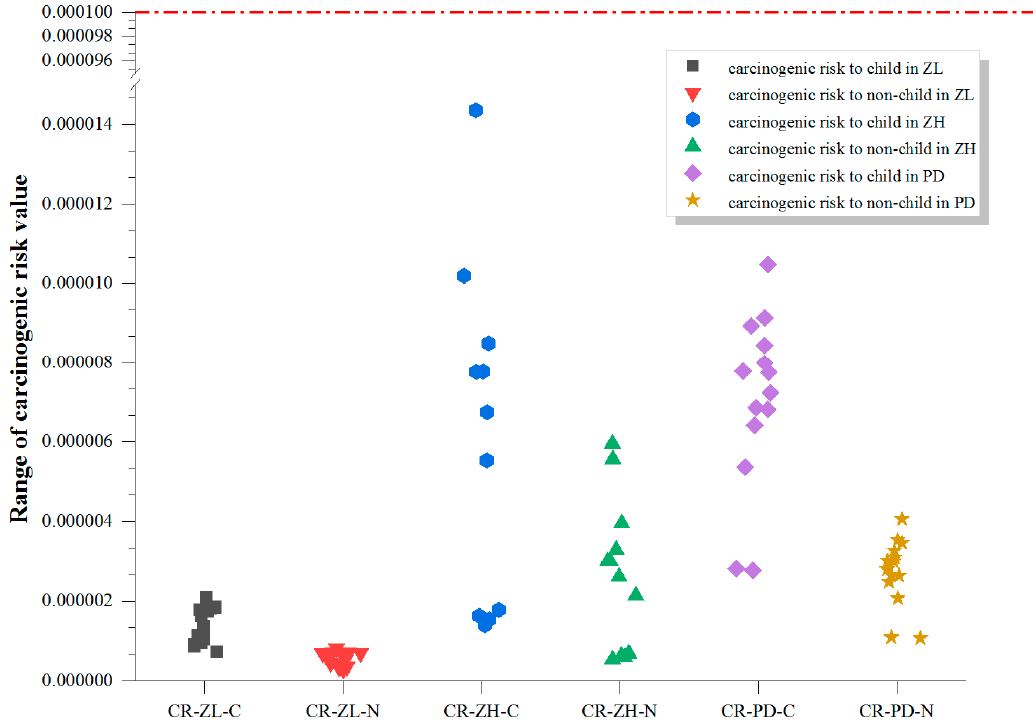
Figure 6. Carcinogenic risk in sampling sites of two of the three study areas. CR-ZL-C denotes carcinogenic risk to young children at Zilingpu, and CR-ZL-N denotes carcinogenic risk to older children and adults at Zilingpu. Other details, see Figure 1.